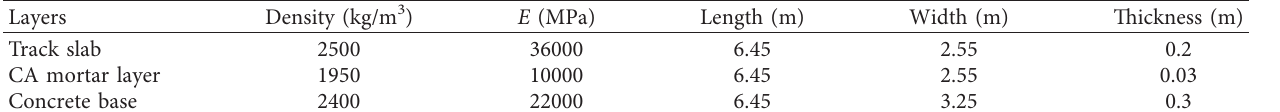
Figure 4: Dimension of the analysis model (a) and the thickness for each layer (b). Table 1: Geometrical and mechanic parameters of the layered model of CRTS II SBTS.